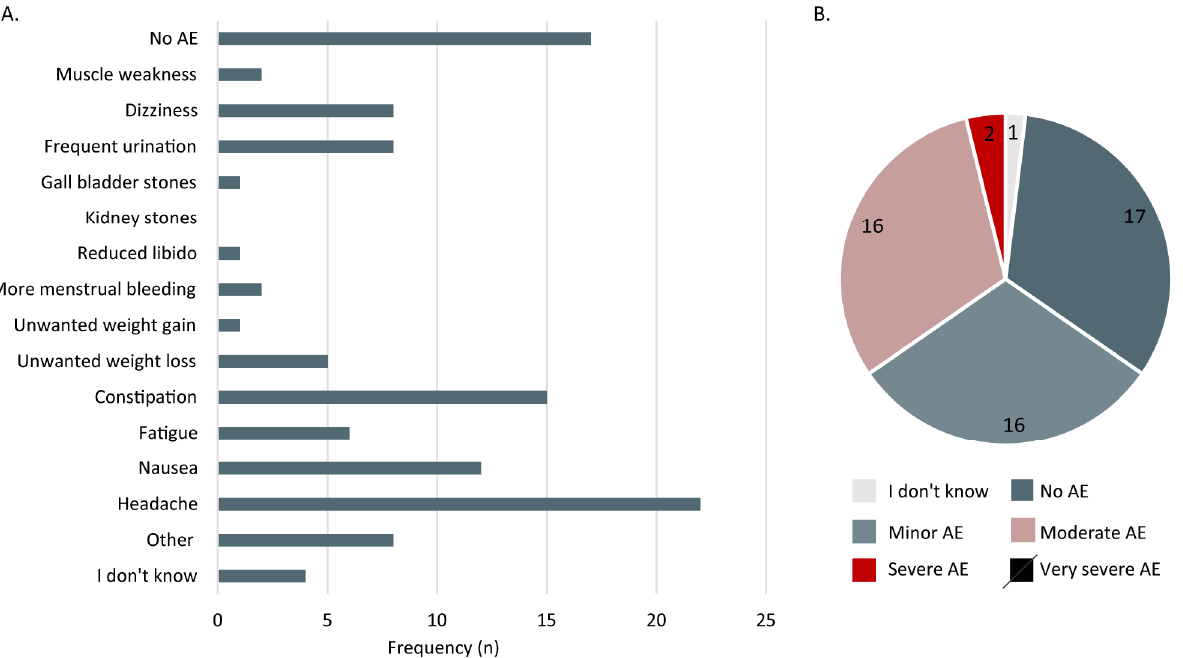
Figure 5. Prevalence of adverse effects ( A ) ( n = 57) and severity of adverse effects ( B ) ( n = 52) experienced on a low carbohydrate ketogenic diet. AE: adverse effects; n: number of patients.